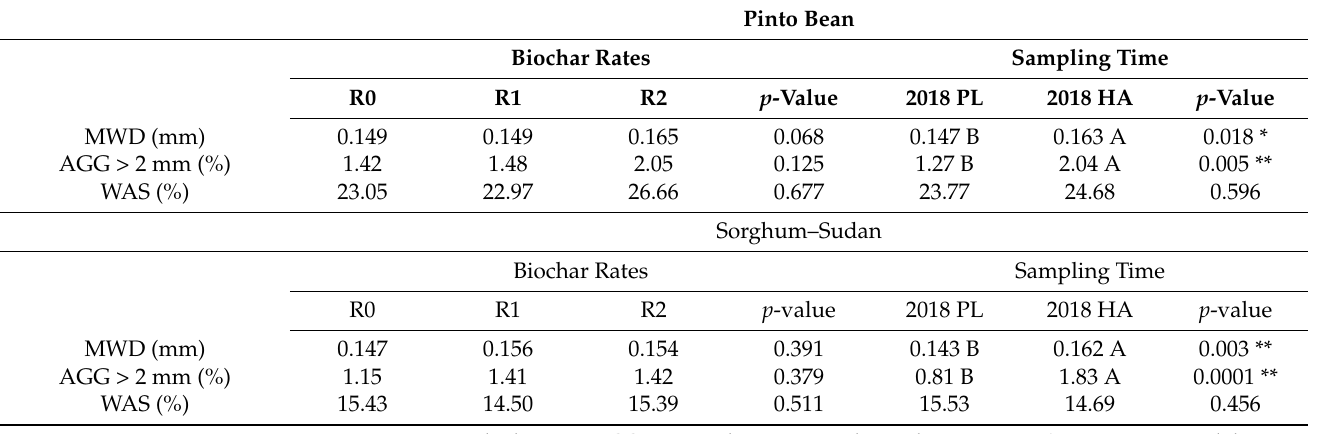
Table 7. Soil physical measurements at different biochar rates before planting (PL) and after harvest (HA) in